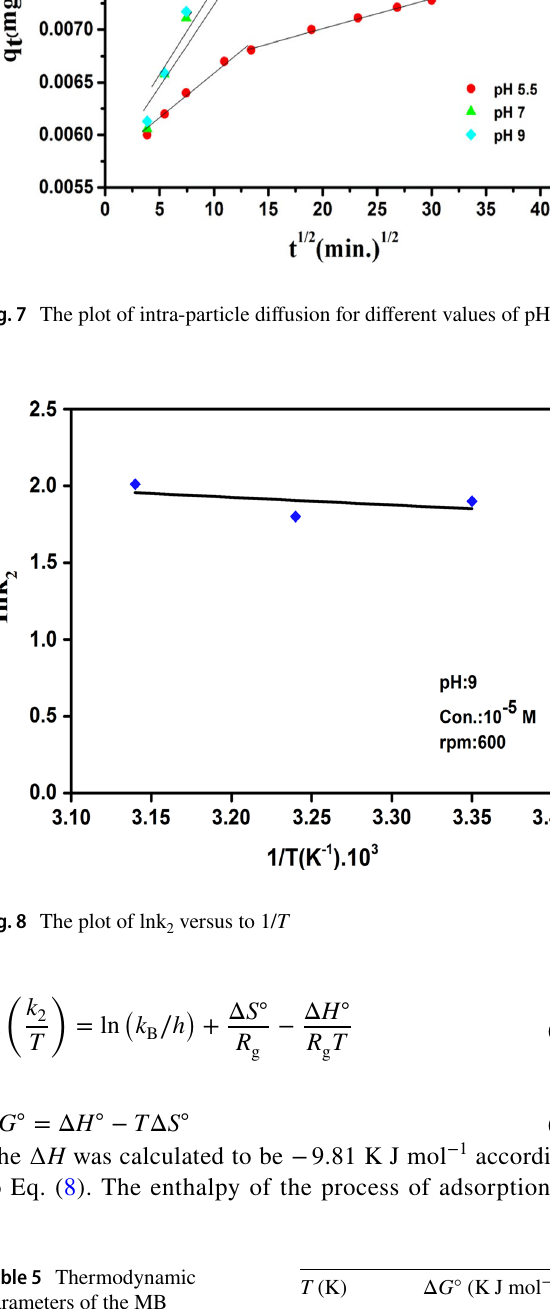
Table 5 Thermodynamic parameters of the MB